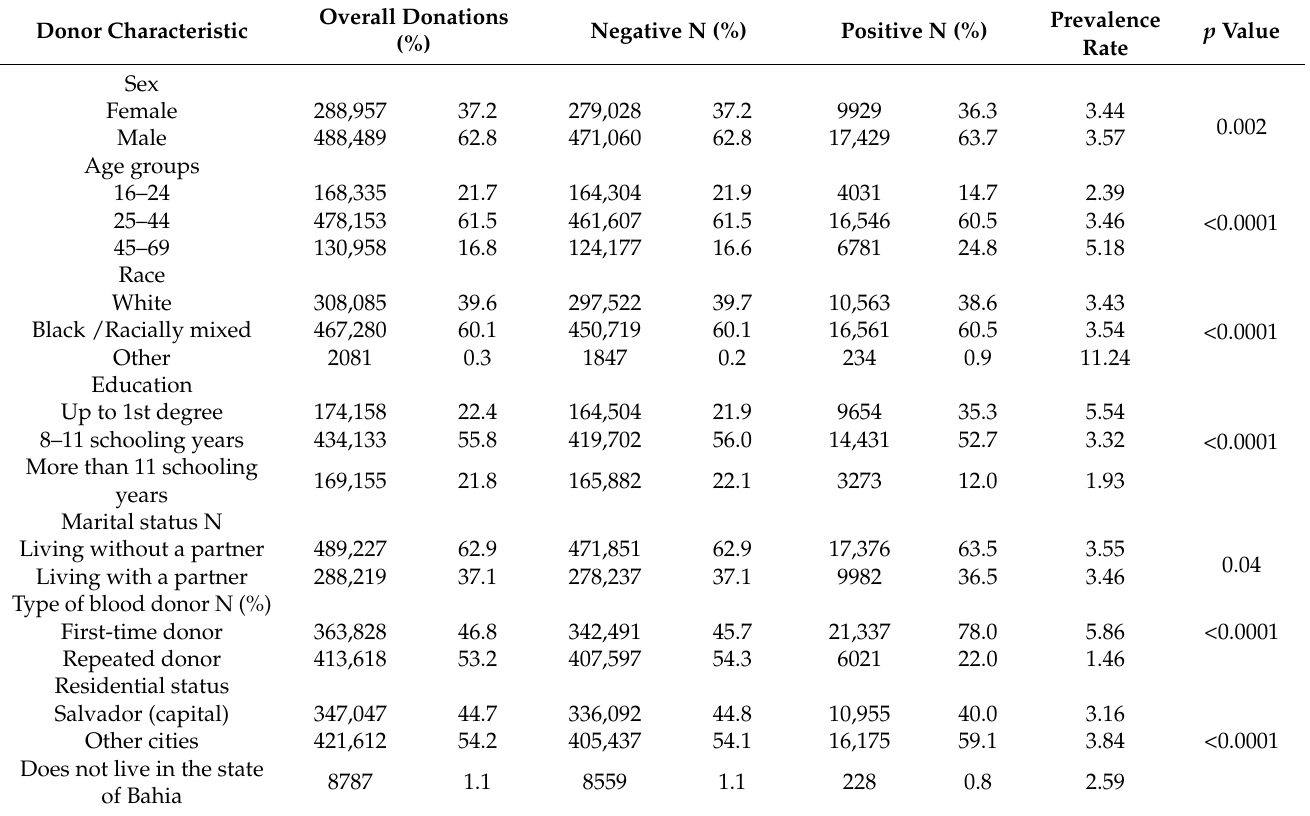
Table 2. Sociodemographic characteristics of Hemoba seronegative and seropositive blood donors for any viruses from February 2008 to December 2017.